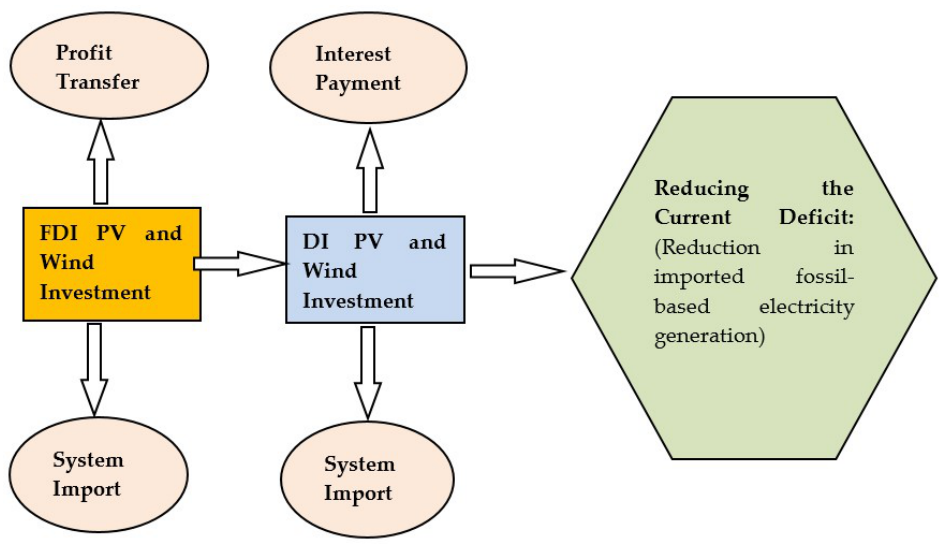
Figure 1. Visual display of the optimization model. Source: Revised from the [55].